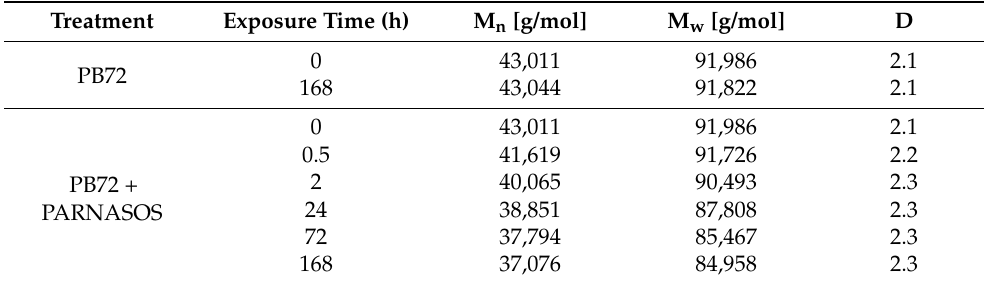
Table 1. GPC data (Mn, Mw, D) for neat and TiO 2 -treated PB72 before and after exposure in the solar box.